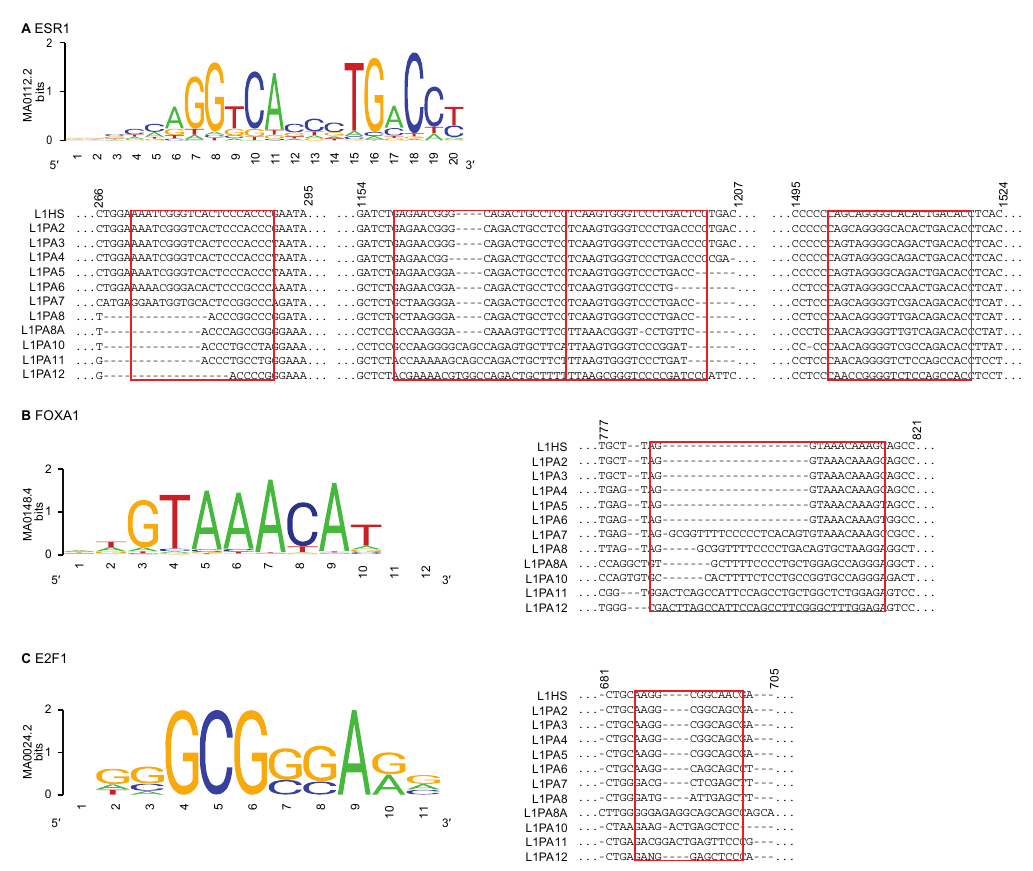
Figure 5. Differential TF binding activities correlated with sequence variations within the L1 5 ′ UTRs. For ( A ) ESR1, ( B ) FOXA1 and ( C ) E2F1, the motif models from the JASPAR database are shown [52]. Regions containing the motif sequences (highlighted in red rectangles) are shown in the multiple sequence alignment of L1 consensus sequences. The numbers correspond to the position of the bases in the multiple sequence alignment.